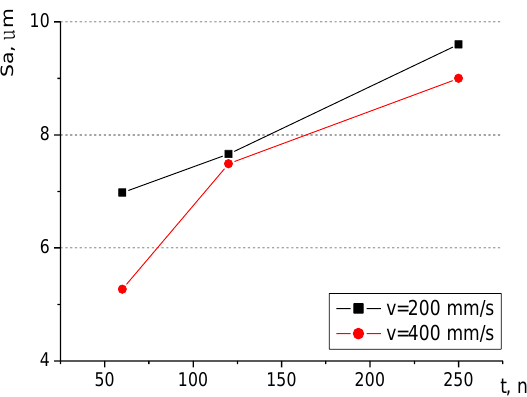
Figure 13. Relationship between pulse duration and surface roughness for two scanning velocities.